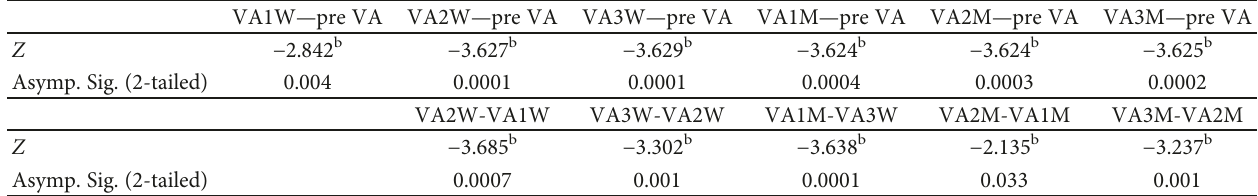
Table 3: Wilcoxon signed-rank test based on positive ranks.